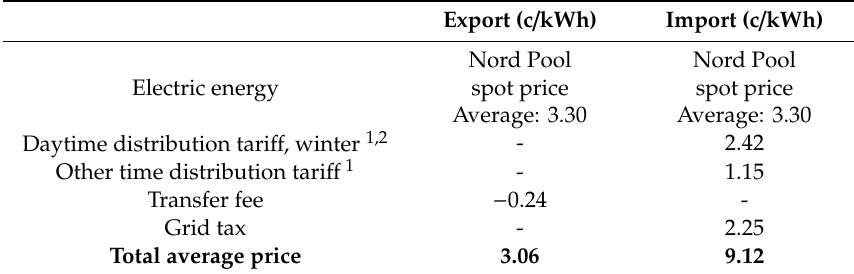
Figure 5. Nord Pool electricity spot prices 2017 [27]. Table 4. Electricity price and tariffs for the case building in Espoo, Finland.